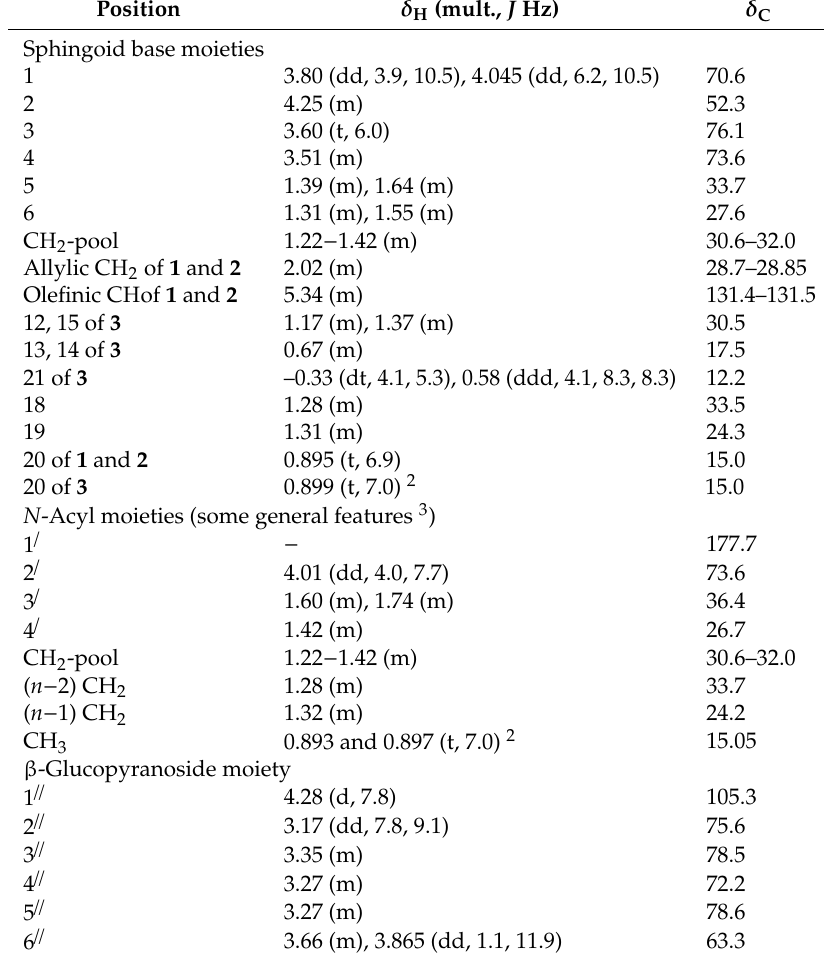
Table 1. 1 Н- (500 MHz) and 13 C-(125 MHz) NMR data (CD 3 OD) 1 for the RP-HPLC fraction, containing compounds 1a – a // , 1b – b // , 2a – a // , 2b – b // , 3c – c // , and 3d – d //